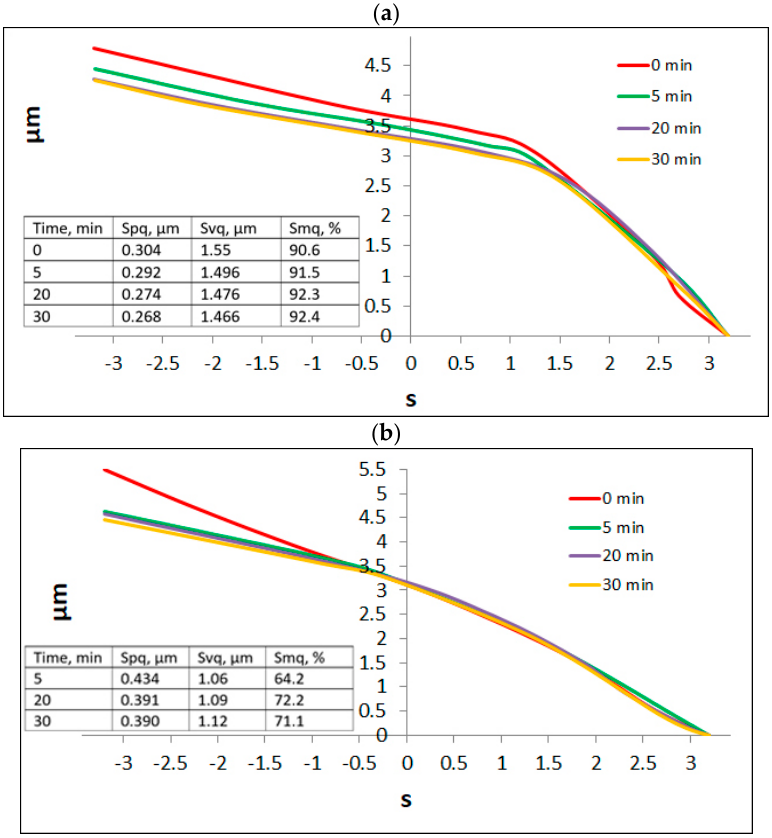
Figure 23. Evolutions of probability plots of the material ratio curve of the initial two—( a ) and one-process ( b ) liners, adapted from [192].